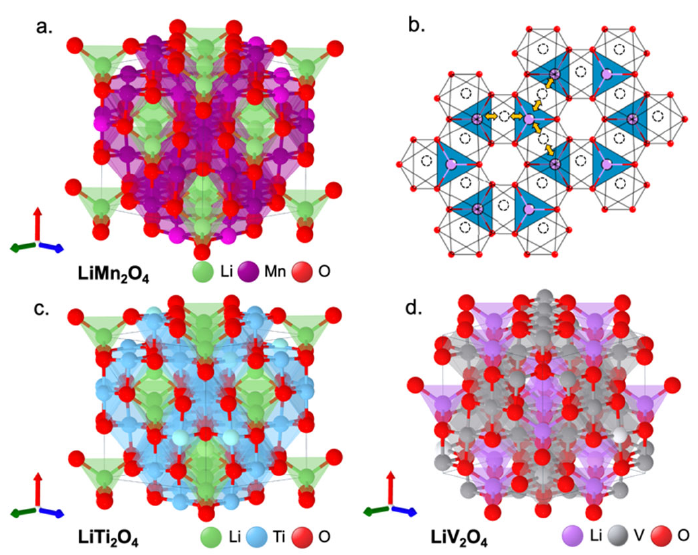
Figure 4. Crystal structures (cubic spinel characterized by space group Fd 3 (cid:3364) m ) of representative A[B 2 ]X 4 framework [41]: ( a ) LiMn 2 O 4 ; ( c ) LiTi 2 O 4 ; and ( d ) LiV 2 O 4 and ( b ) Li-ion diffusion in the framework (Adapted from Ref.